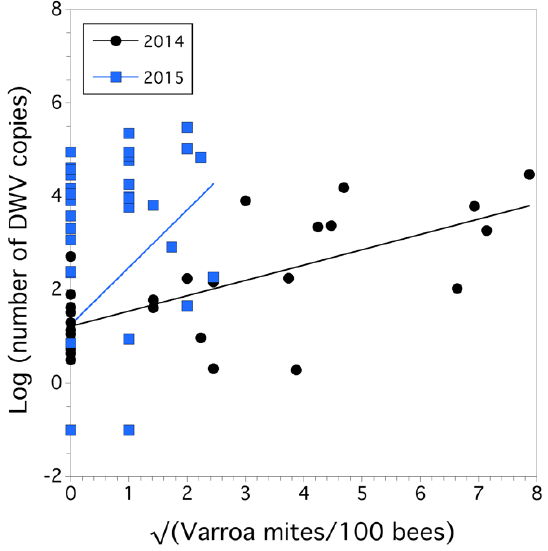
Figure 8. Relationship between Varroa mite infestation level (sqrt transformed) and the intensity of DWV infection (logarithm base10 (number of DWV copies) for each